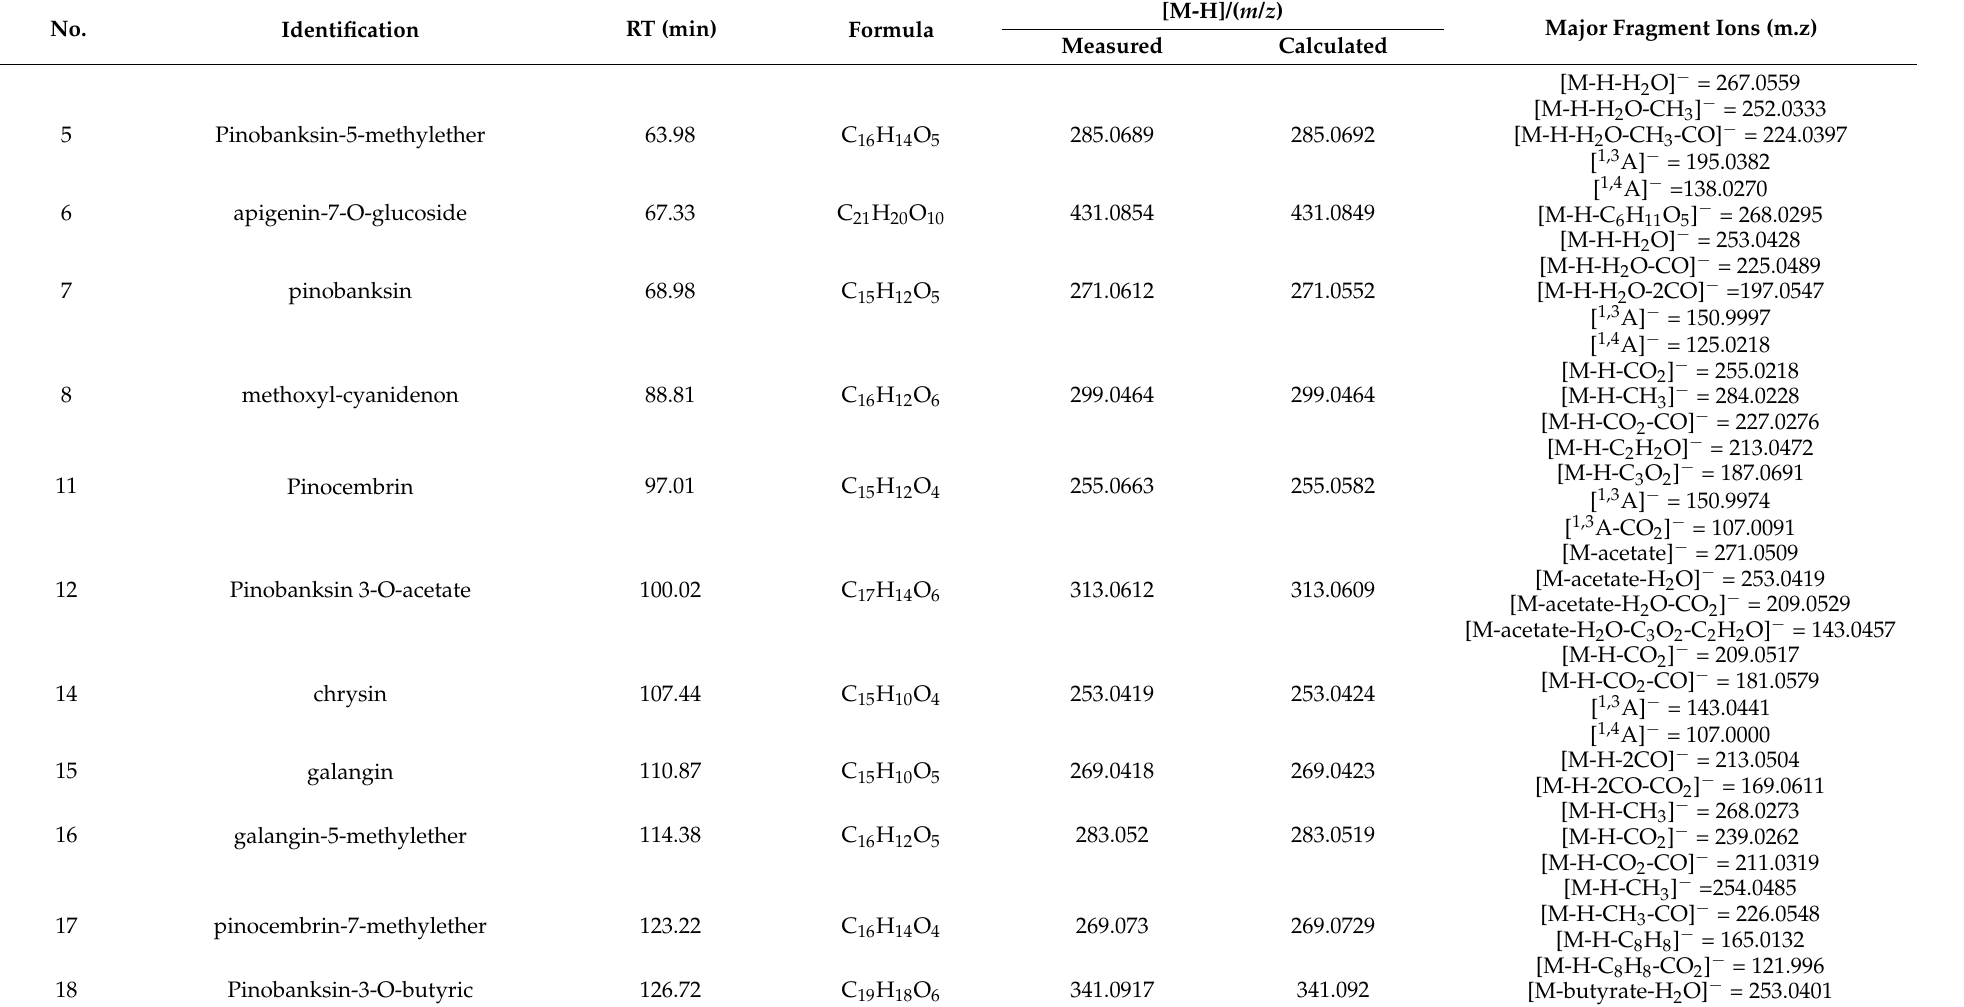
Table 1. Flavonoids in propolis extract determined via HPLC-TOF-MS